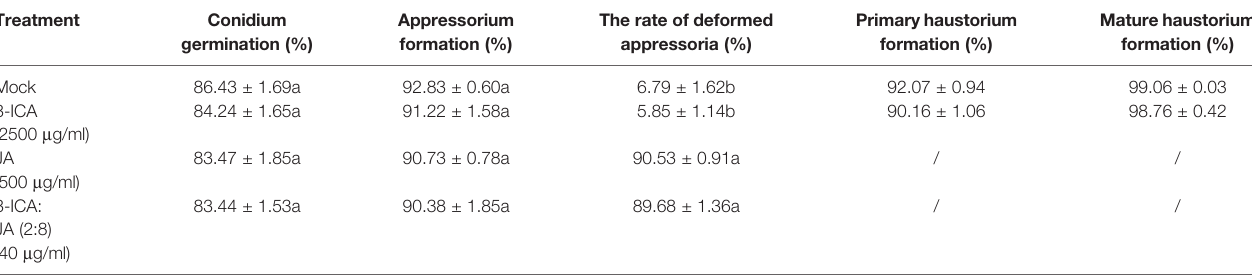
TABLE 4 | Histological investigation of the infection process of B. graminis after treatment with 3-ICA, JA, and their combinations. Treatment Conidium germination